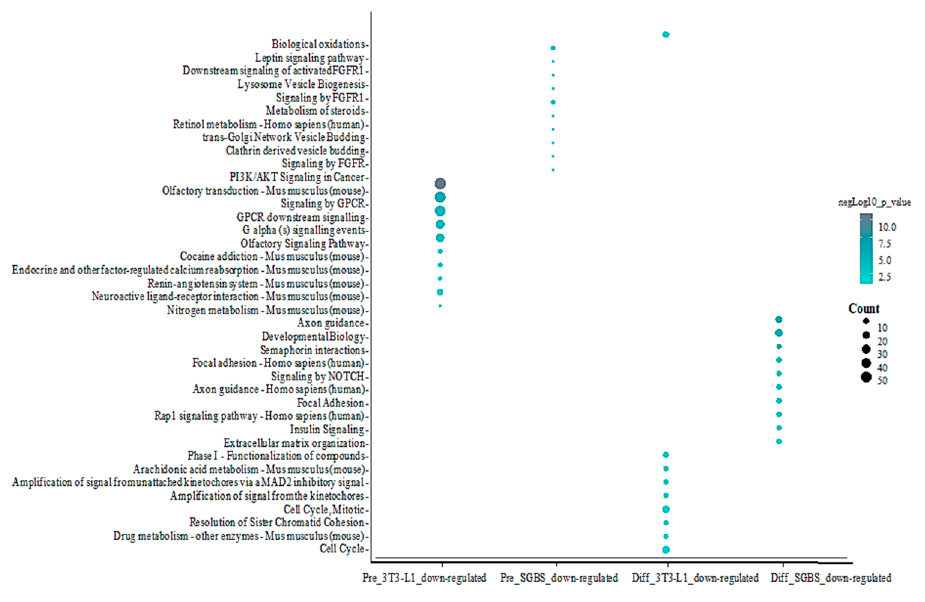
Figure 5. Pathway enrichment analysis in pre- and differentiated SGBS and 3T3-L1 adipocytes. The top 10 enriched pathways for upregulated DEGs ( A ) and downregulated DEGs ( B ) DEGs are plotted separately. Size of the bubbles indicated the count of genes identified in each pathway, and color of the bubbles show significance ( − log 10 p -value) of enriched pathway compared to control.